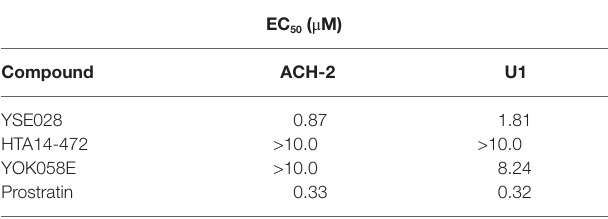
TABLE 3 | Latency-reversing agent activity of the tested compounds in ACH-2 and U1